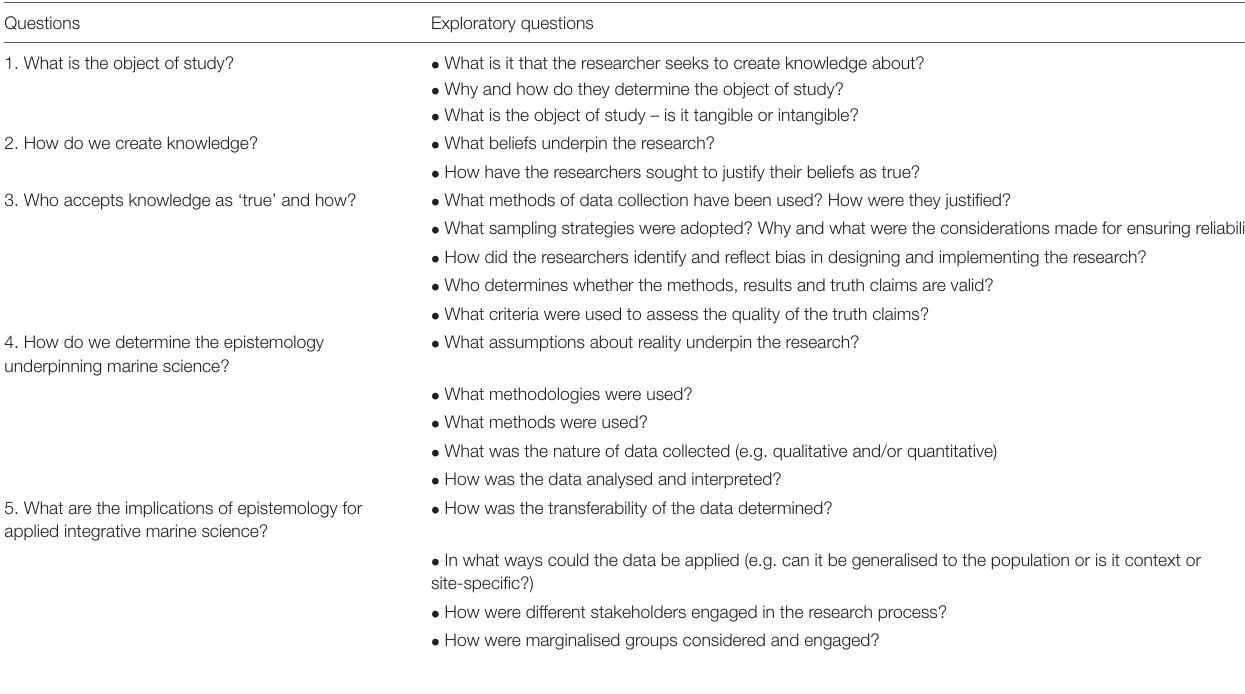
TABLE 2 | Questions to ask in understanding the epistemology of marine